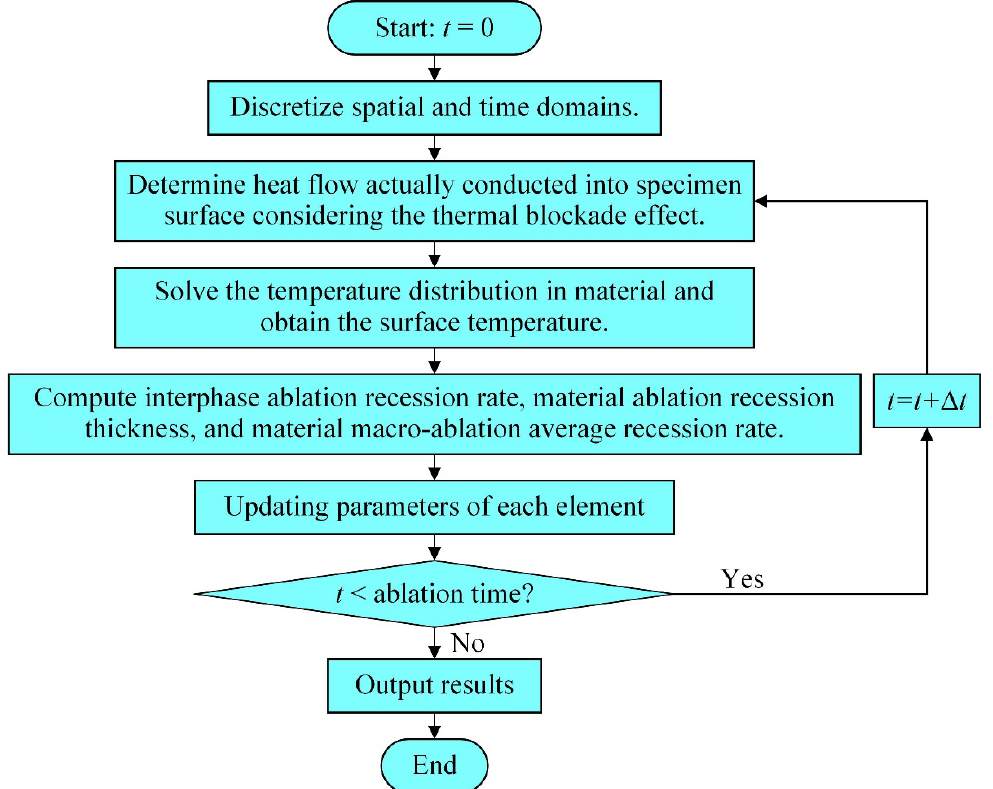
Figure 5. Solution flow chart for ablation performance of carbon/carbon composite.